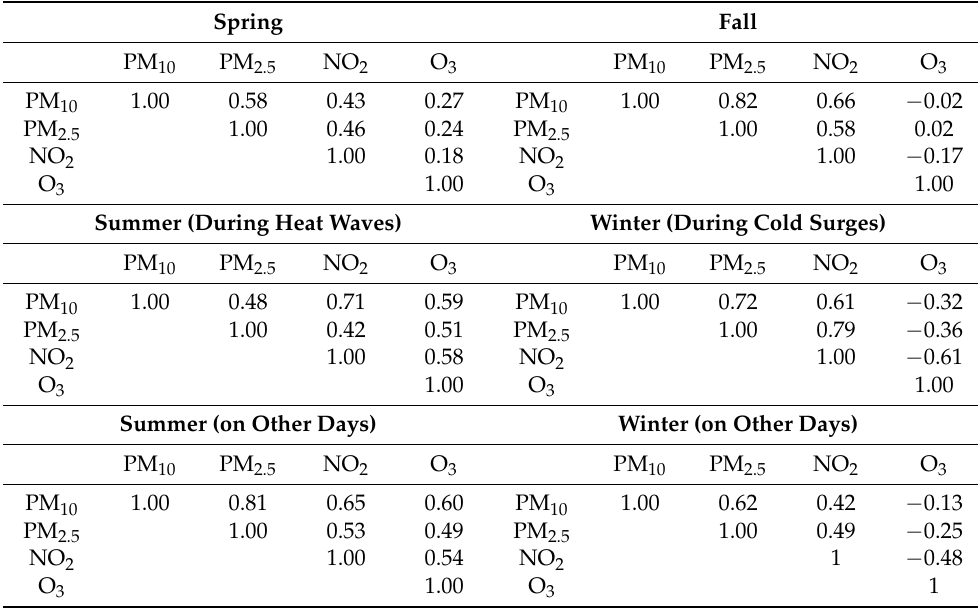
Table 4. Correlation coefficient (r) between hourly pollutant concentrations of PM 10 , PM 2.5 , NO 2 , and O 3 from 2008 to 2018 in Seoul,